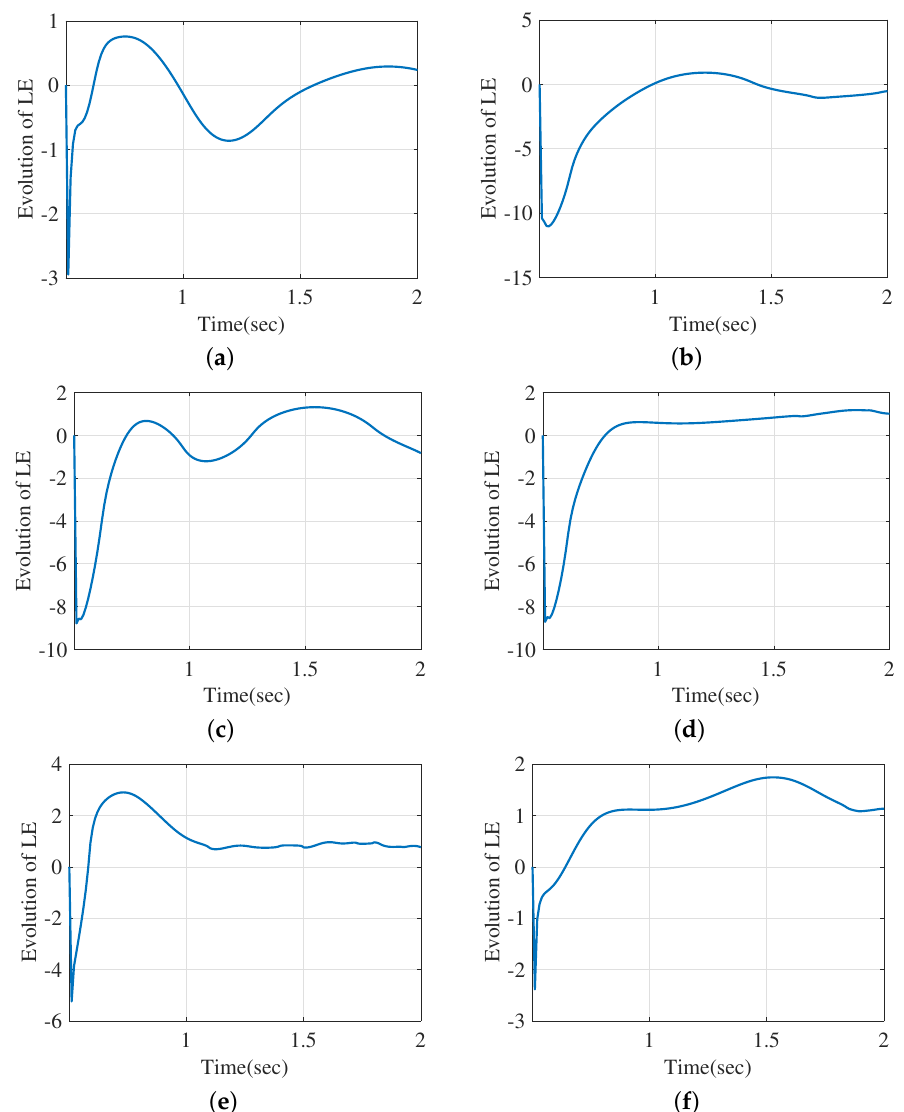
Figure 3. System LE evolution for six defined scenarios: ( a ) Case a, ( b ) Case b, ( c ) Case c, ( d ) Case d, ( e ) Case e, ( f ) Case